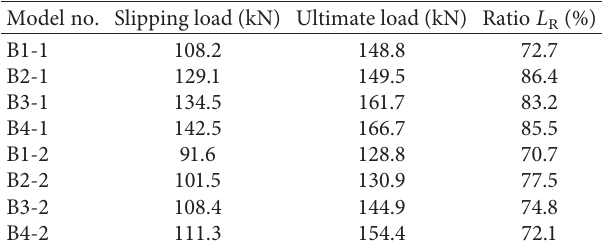
Figure 7: SDEG curves of stack-poured beams. (a) 45 minutes casting interval time. (b) 14 days casting interval time. Table 9: Slipping loads and ultimate loads of beam